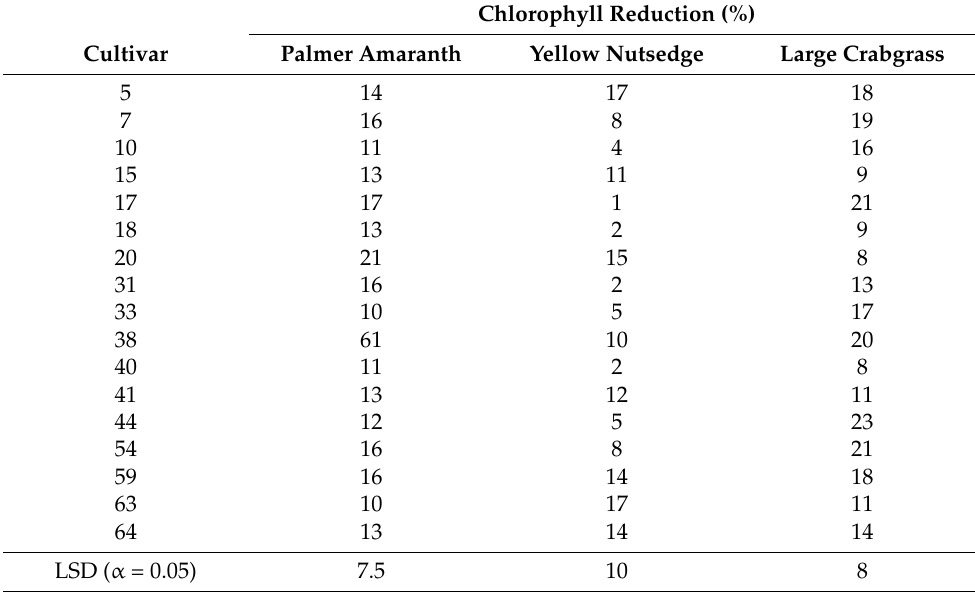
Table 2. Percentage of chlorophyll reduction of Palmer amaranth, yellow nutsedge, and large crabgrass across 17 tomato cultivars, at 28 days after sowing. Four tomato plants and four plants of a single weed species were grown together in the same pot. The reduction values were based on a comparison to plants of individual weed species grown as a control treatment without tomato interference. Error bars represent the standard deviation of the mean. The difference between the two mean values is compared to the least significant difference (LSD) value. If the difference was greater than the LSD value, then the means are significantly different according to Student’s t -test at a 0.05 probability level. Chlorophyll Reduction (%) Cultivar Palmer Amaranth Yellow Nutsedge Large